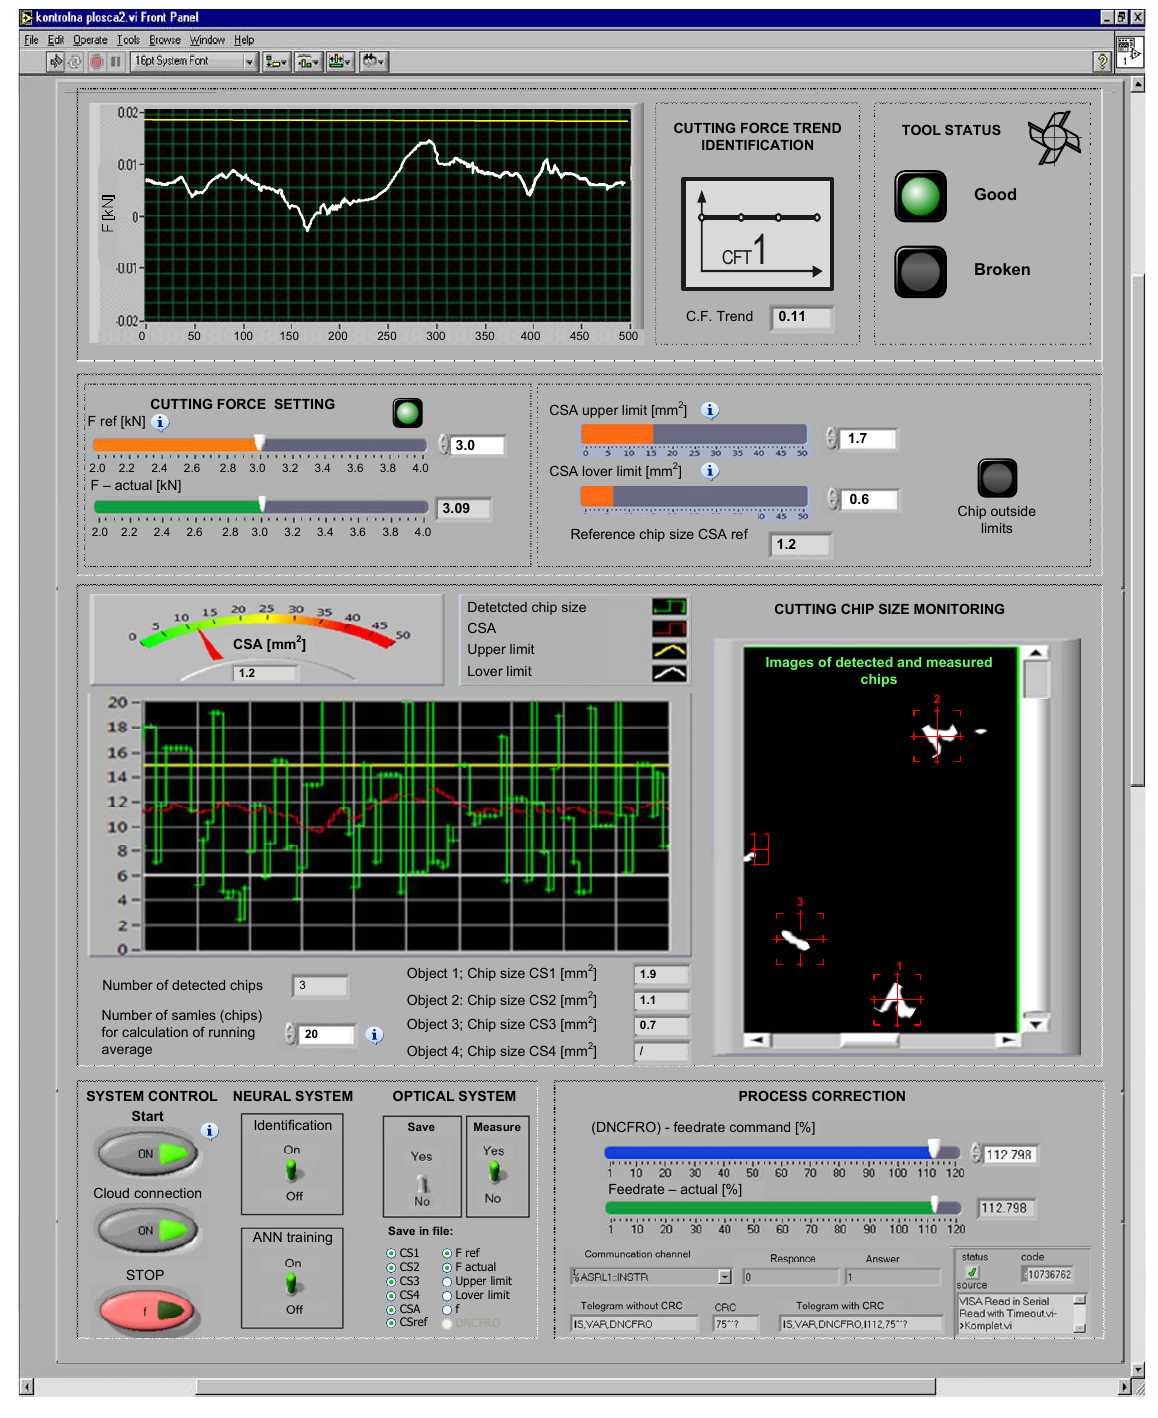
Figure 4. Monitoring window of the application for tool condition and milling process monitoring.